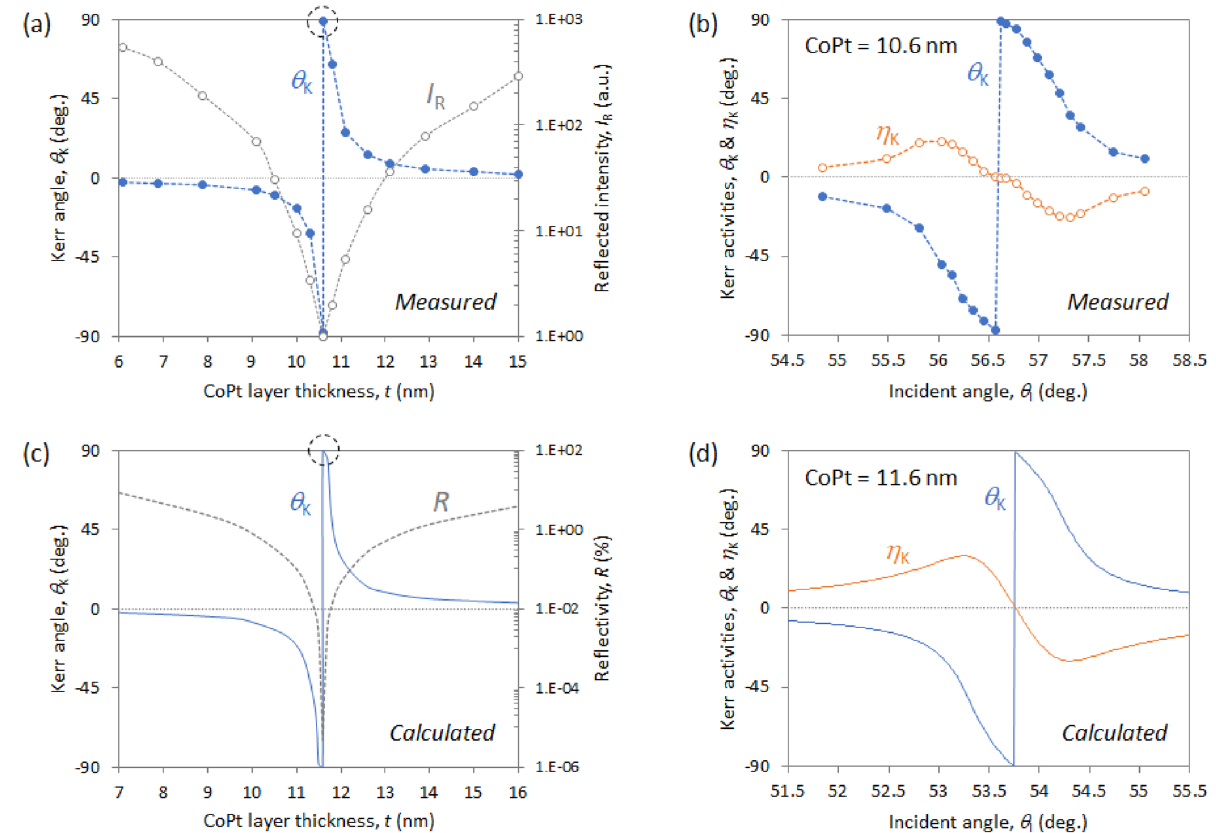
Figure 2. Experimentally measured ( a , b ) and analytically calculated ( c , d ) optical and MO responses for Al 2 O 3 (5 nm)/CoPt ( t nm)/AZO (30 nm) trilayers in the polar Kerr excitation geometry. ( b ) Measured and ( d ) calculated Kerr activities ( θ K and θ K ) as a function of incident angle of radiation for samples containing 10.6- and 11.6-nm-thick CoPt layers, respectively. For the simulations at 658 nm, Table 1 lists the dielectric constants used for each